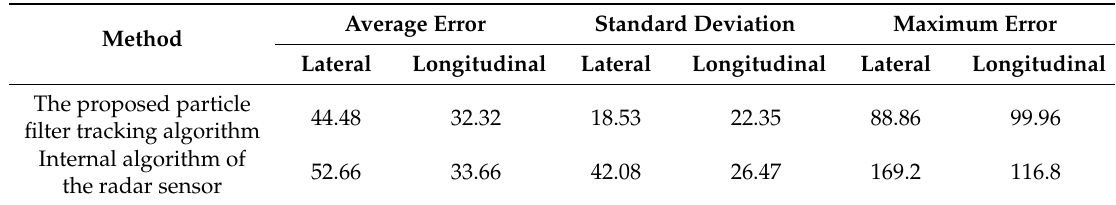
Table 1. Error of each tracking methods (unit: centimeter).